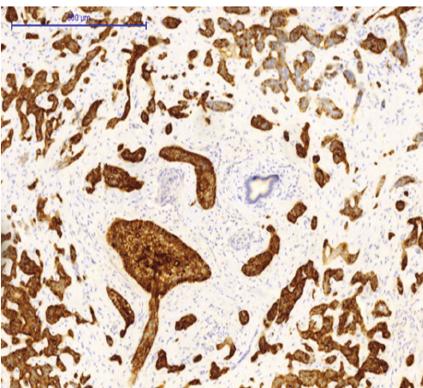
Figure 7: CK5/6 immunohistochemical staining. Hepatic BSCC shows intense staining in the tumor cells, whereas the benign bile duct in the center is negative.